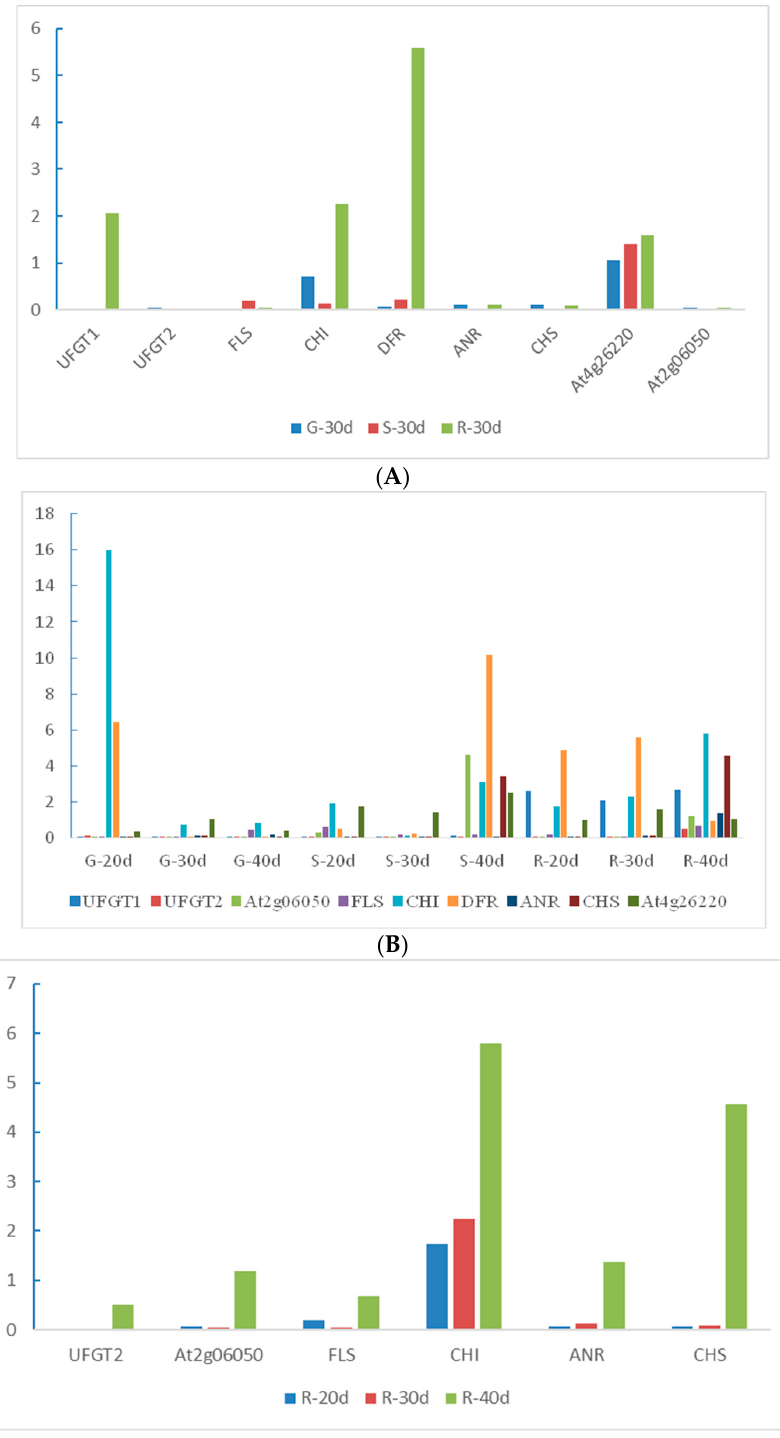
Figure 8. Expression patterns of nine genes obtained from RT-qPCR experiments. Relative expression values, normalized to NADPH, are shown as 2 − ∆∆ Ct relative to the mean expression levels in roselle calyxes. ( A ) Relative gene expression of nine candidate genes in different cultivars at 30 days after flowering (DAF). ( B ) Relative expression levels of nine candidate genes determined using qRT-PCR. ( C ) Relative expression of genes negatively related to anthocyanin synthesis at 20–40 DAF in the R cultivar. R, FZ-72 (red calyx); G, Baitao K (green calyx); S, MG5 (stripped